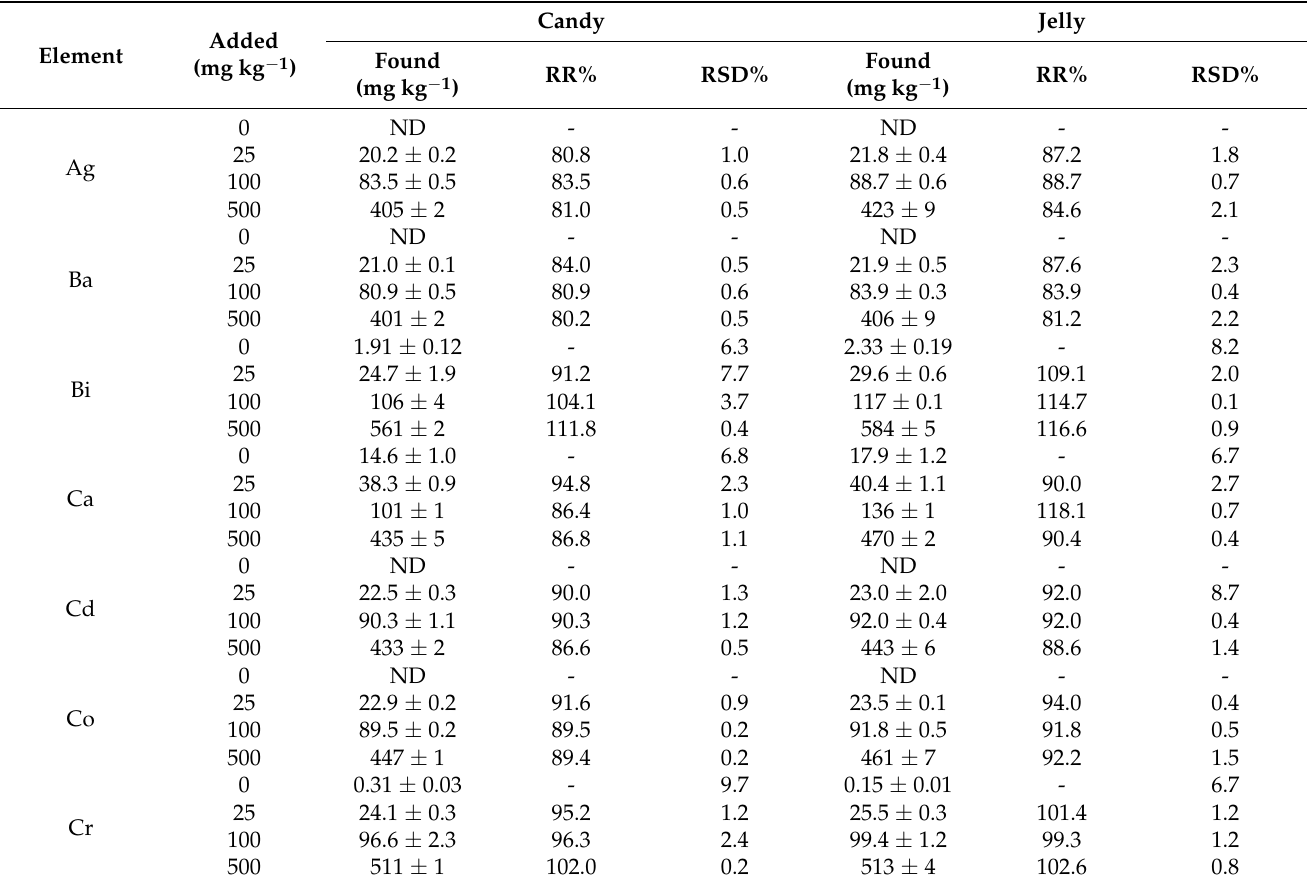
Table 5. Accuracy and precision of the determination of nutrient and toxic elements by